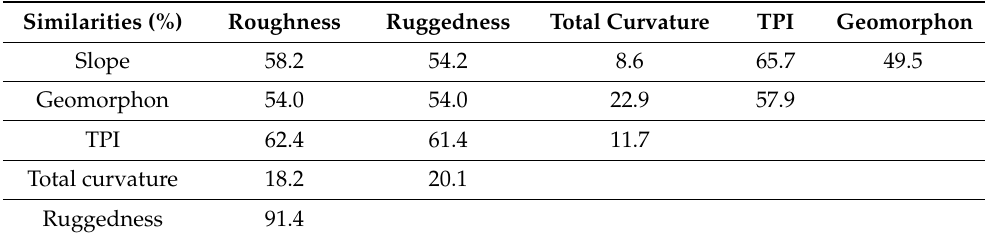
Table 3. Comparison of results of geodiversity assessment based on different geomorphological models evaluated with equal